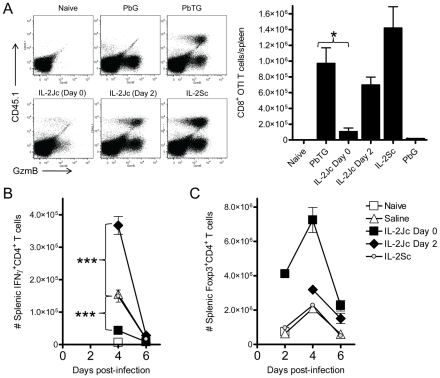
IL-2Jc-mediated protection is associated with impaired expansion of antigen-specific CD8+ T cells, reduced effector CD4+ T cell responses, and Treg cell expansion.A) C57BL/6 mice were adoptively transferred with 10,000 CD8+ CD45.1+ OTI T cells, and infected with SIINFEKL-expressing transgenic PbTG. Control mice were infected with non-SIINFEKL-expressing PbG parasites. PbTG-infected mice were i.p. treated with IL-2Jc (day 0 or day 2), IL-2Sc (day 0), or control saline. On day 6 p.i., when control mice were displaying ECM symptoms, splenic CD8+ T cells (gated in FACS plots) were assessed for the presence of CD45.1+ SIINFEKL-specific T cells, and expression of the activation marker, GzmB. The graph indicates the number of CD45.1+ CD8+ SIINFEKL-specific T cells per spleen. Mann-Whitney * p<0.05. These data are representative of 2 independent experiments. B&C) C57BL/6 mice (n = 5) were infected with PbA, and i.p. treated with IL-2Jc (day 0 or day 2 p.i), IL-2Sc (day 0) or control saline. On days indicated, splenocytes were assessed directly ex vivo for the number of B) IFNγ-producing effector CD4+ T cells and C) CD4+ Foxp3+ Treg cells. Mann-Whitney: ***p<0.001. These data are representative of 2 independent experiments.